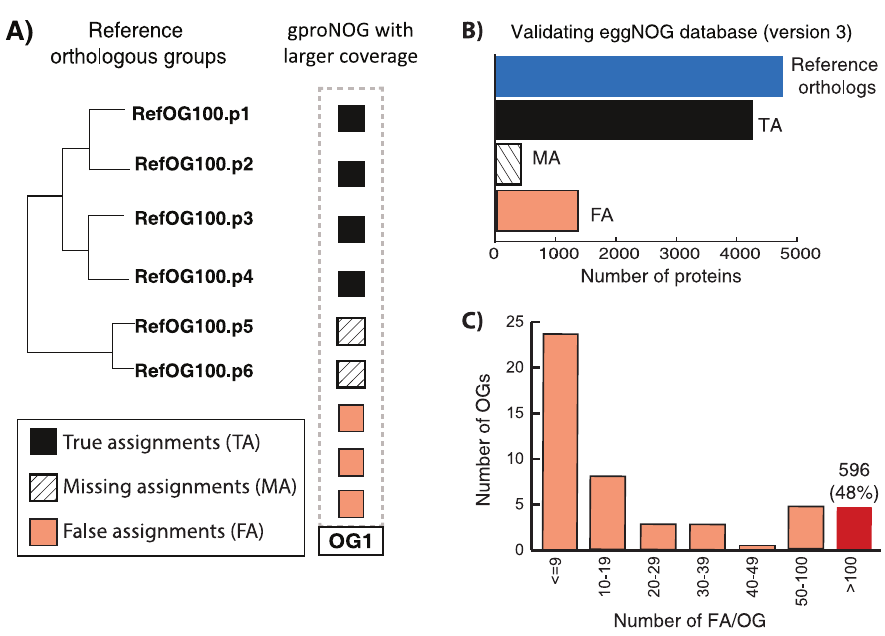
Figure 2. Benchmarking eggNOG database. A) To evaluate the performance of the database, we map the members (p1-p6) of every reference orthologous group (i.e. RefOG100) to the predicted orthologous groups and use the orthologous group with the highest coverage (i.e. OG1). Three classes of assignments are defined using OG1 orthology predictions: True assignments (TA) are the orthologs that have been grouped correctly in the database (black box). Missing assignments (MA) are the reference orthologs that were incorrectly excluded by the method (white stripped box). False assignments (FA) are those predictions that have been grouped in OG1, but are not reference orthologs (light red box). B) The number of true, false and missing assignments for eggNOG gamma-proteobacteria-specific orthologous groups (gproNOGs) applying the aforementioned scoring scheme. C) Distribution of FA per orthologous group. Half of the orthologous groups have less than 10 false assigned proteins ( , =9), contributing in less than 10% of this error category. The red box highlights five families that contribute to the , 50% of the FA.